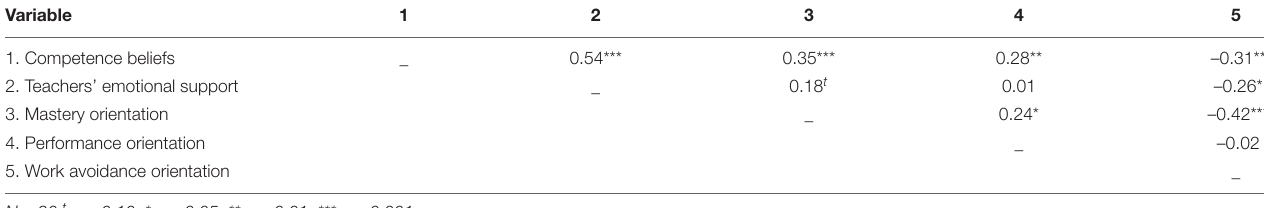
TABLE 2 | Correlations for mastery, performance and work avoidance orientations. Variable